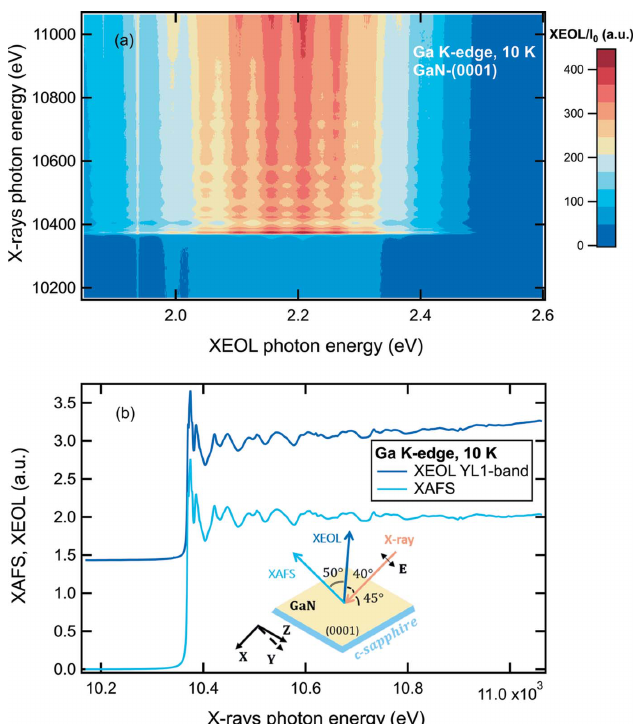
Figure 5 ( a ) 2D-XEOL-XAFS mapping across the Ga K -edge ( E K = 10367 eV) at 10 K on a single-crystalline GaN-(0001) thin film grown on a crystalline sapphire substrate. ( b ) Comparison of the XEOL intensity (offset along the y -axis) of the YL1 defect band and the fluorescence XAFS measured simultaneously as a function of the incident X-ray energy. The inset schematically illustrates the sample orientation relative to the polariza- tion vector E of the incident X-ray beam and the direction of the collected XEOL and X-ray fluorescence XAFS